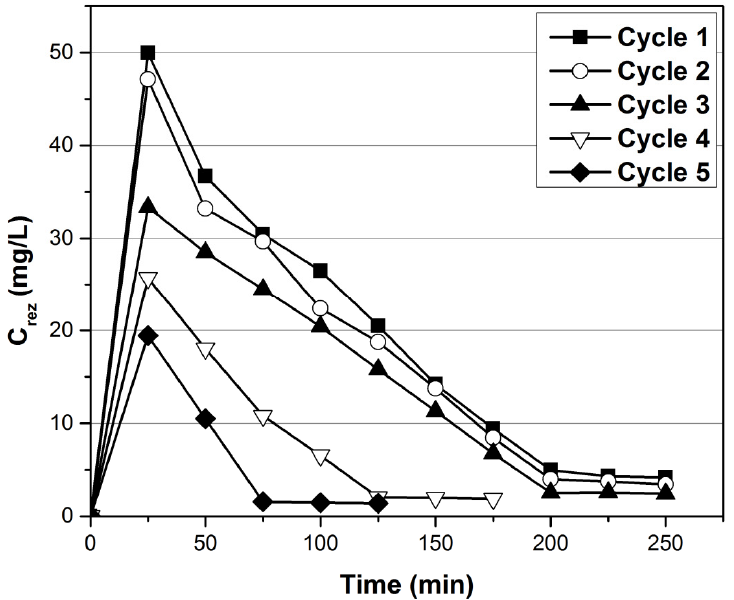
Figure 9. Desorption curves of Au (III) adsorbed on XAD7-AcG (10 g amounts), in five adsorption–desorption cycles.